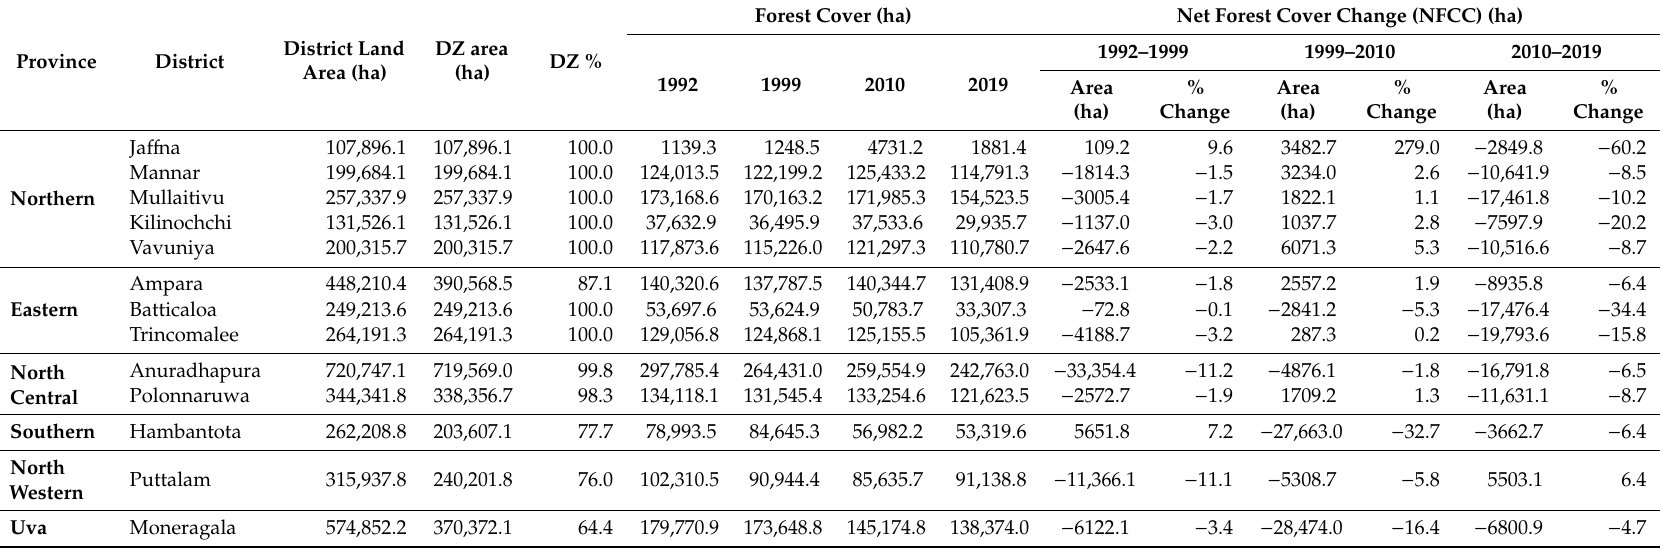
Table A2. Forest cover changes in the DZ of Sri Lanka in 13 administrative districts. The districts with area covering less than 25% DZ were excluded from the analyses (Matale = 24%, Kurunegala = 20.9%, Badulla = 11.1%, and Ratnapura =